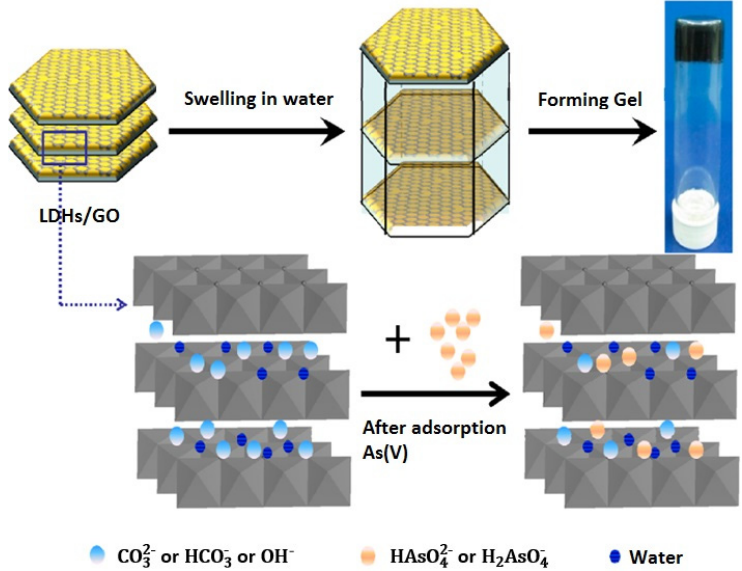
Figure 8. Mechanism for the adsorption mechanism of Arsenic on GO-LDH (Reproduced or adapted from ref. [52], with permission from American Chemical Society, 2020).